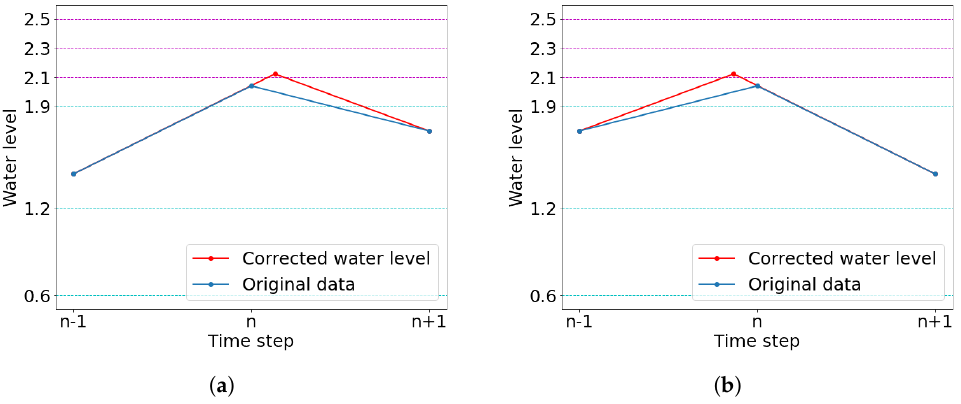
Figure 6. The 2 sub-cases of case D1. ( a ) Illustration of case D1 (i): f n − 1 = 1.435, f n = 2.04 and f n + 1 = 1.73). ( b ) Illustration of case D1 (ii): f n − 1 = 1.73, f n = 2.04 and f n + 1 =